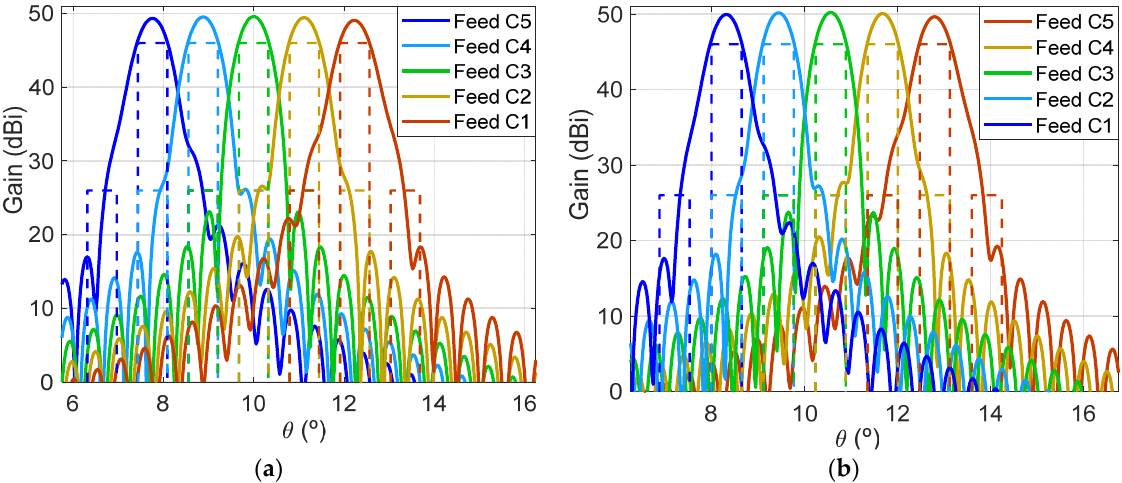
Figure 8. Cut of the simulated radiation patterns in v = 0 for the beams generated at the ( a ) lower and ( b ) upper frequency in the same circular polarization (CP).